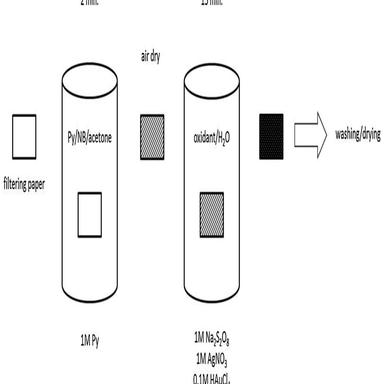
Scheme of the polymerization procedure leading to obtain thin layers of polypyrrole and its composites on the surface of filtering paper.